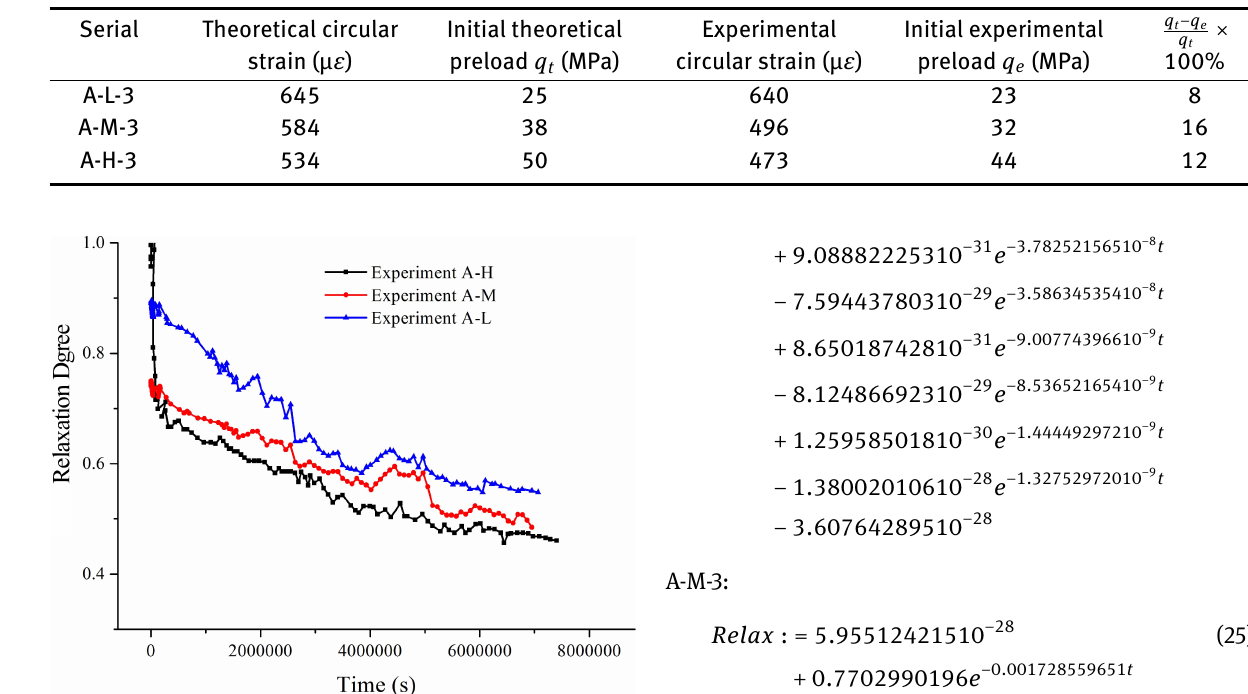
Table 3: Design values and test values of the outer tube circular strain and preload